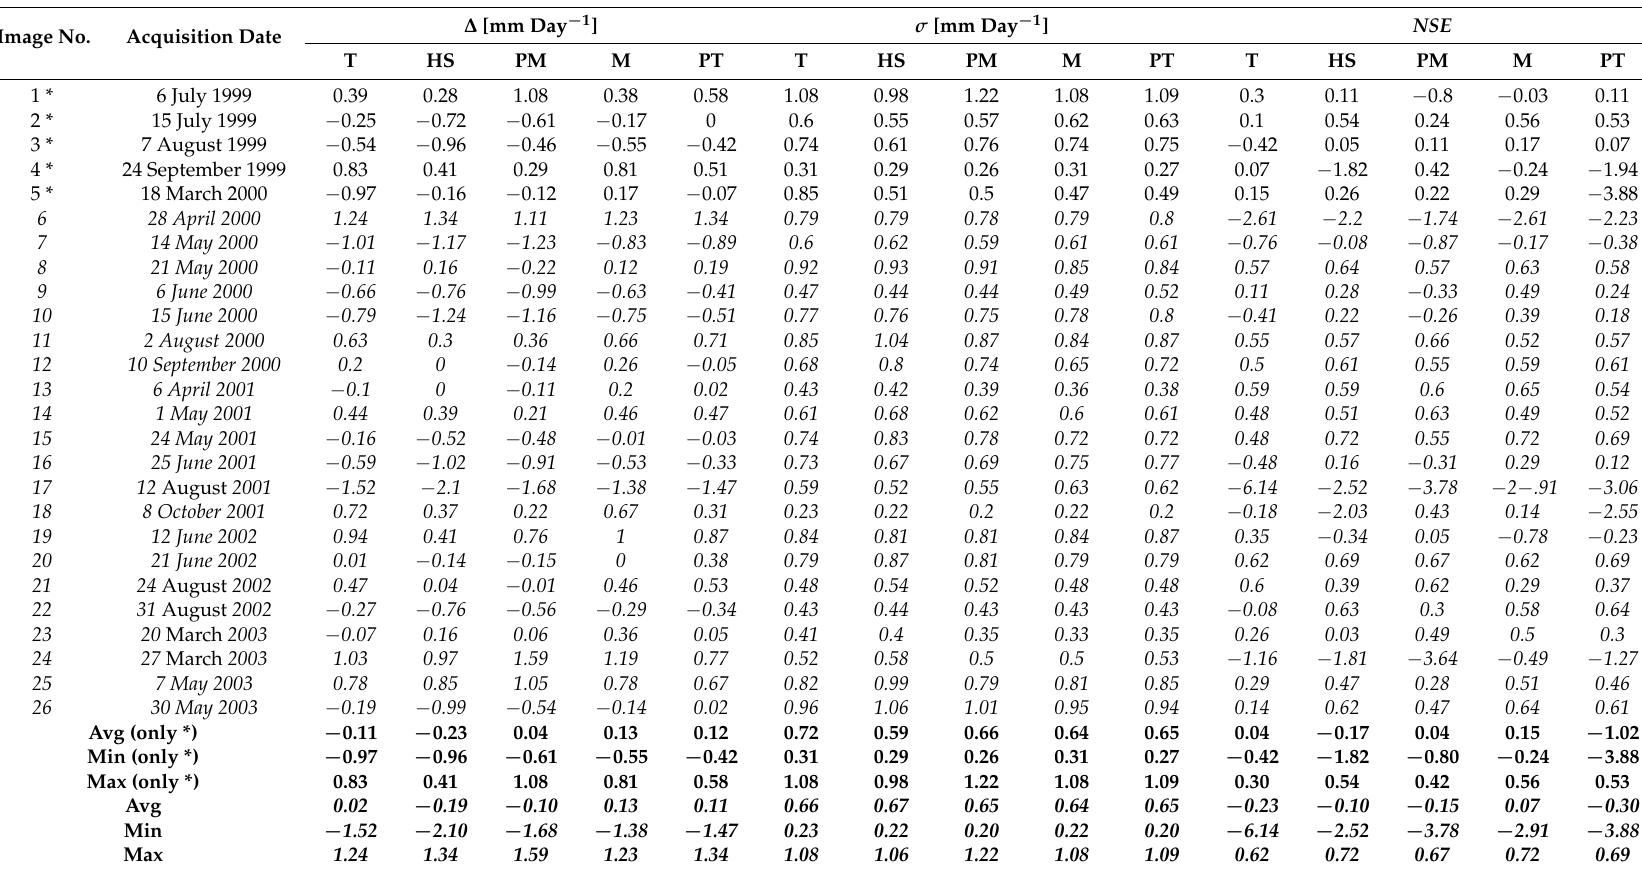
Table 3. AET raster residuals ( ∆ ), standard deviation of the residuals ( σ ) and the Nash–Sutcliffe efficiency ( NSE ) for PET variations. Image